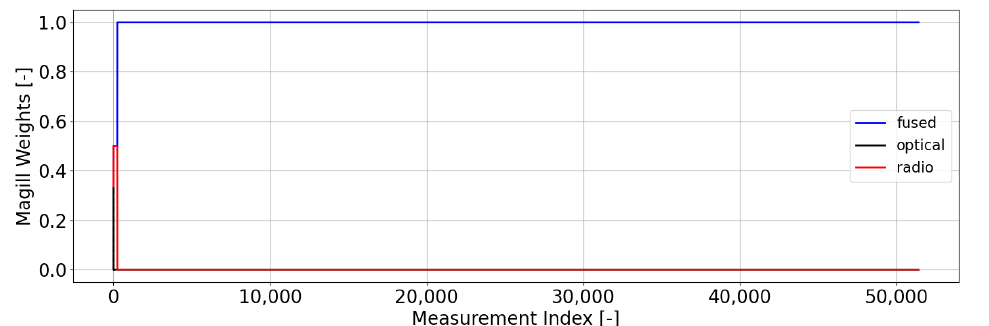
Figure 10. Magill gating network weights with biased optical